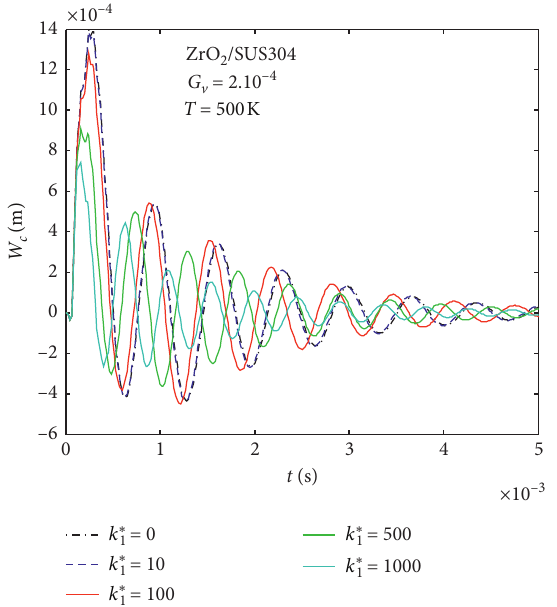
Figure 15: The dependence of w � 10, G � 2.10 − 4 k ∗ v 2